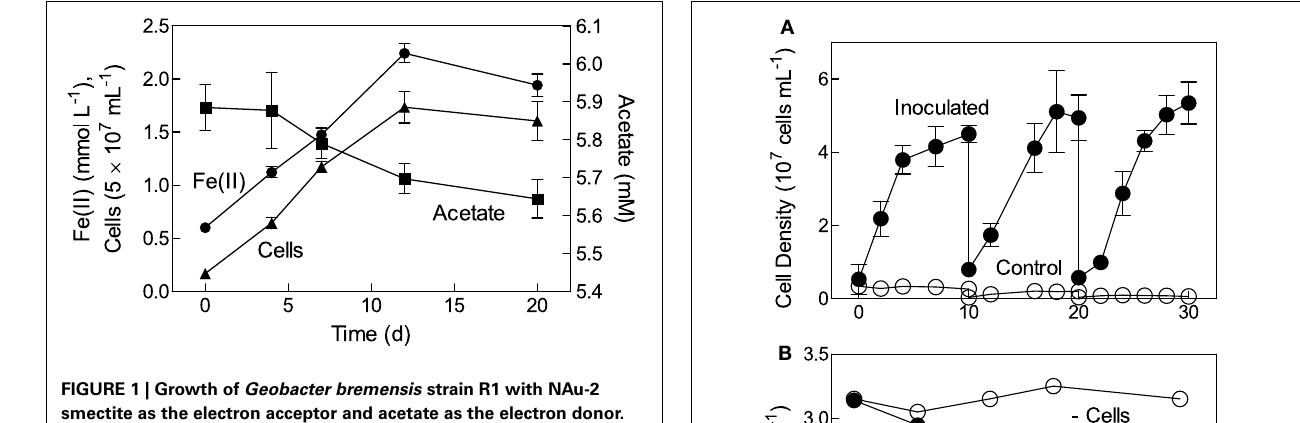
in reduced NAu-2 smectite with nitrate as the electron acceptor ( Figure 2C ). The extent of biotite oxidation (ca. 5% of total